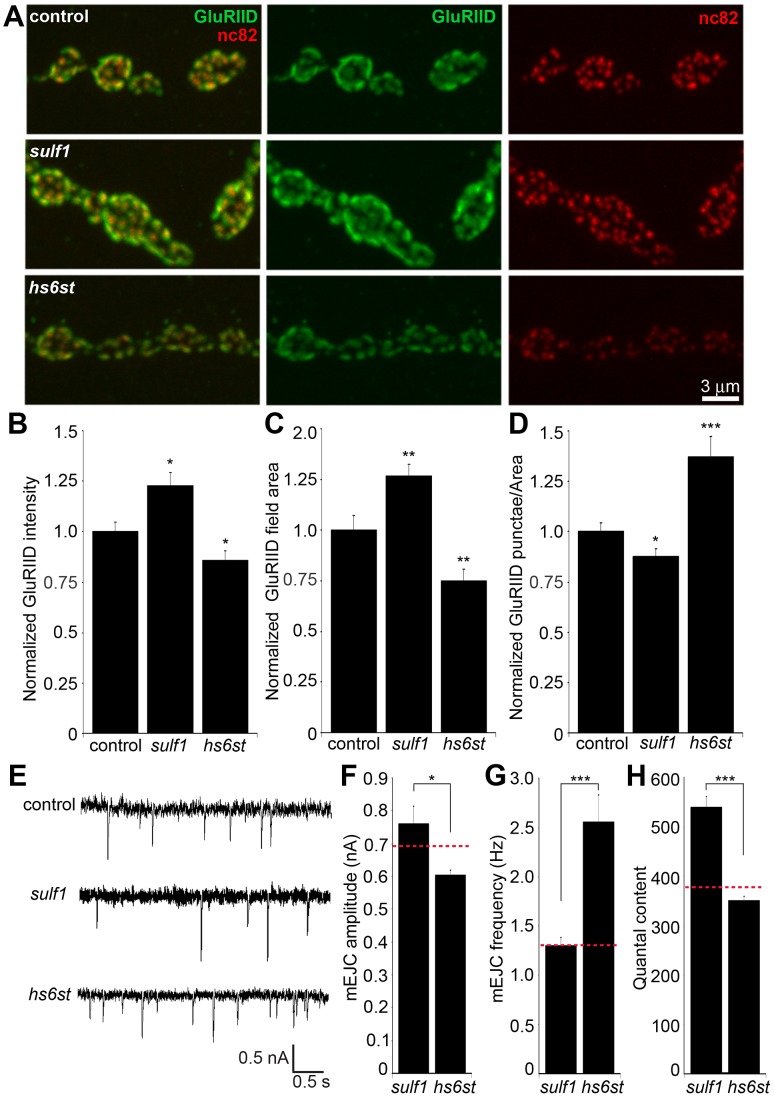
Bi-directional effects of sulf1 and hs6st nulls on synaptic assembly.(A) Representative NMJ boutons from control (w1118), sulf1 and hs6st null genotypes, labeled for postsynaptic Bad Reception (Brec) glutamate receptor IID subunit (GluRIID, green) and presynaptic active zone Bruchpilot (anti-nc82, red). Quantification of GluRIID mean fluorescent intensity (≥18 animals per indicated genotype) (B), GluRIID field area (≥40 boutons from ≥9 animals per indicated genotype) (C), and GluRIID punctae number per synaptic bouton (≥40 boutons from ≥9 animals per indicated genotype) (D), all normalized to genetic control. (E) Representative mEJC traces from control (w1118), sulf1Δ1 and hs6std770 null alleles. Quantified mean mEJC amplitude (nA) (F), mean mEJC frequency (Hz) (G) and mean quantal content (H), with genetic control levels indicated as a dotted red line in each case. Sample sizes ≥15 recordings per indicated genotype. Statistically significant differences calculated using student's t-test or Mann-Whitney test for non-parametric data and indicated as, * p<0.05, ** p<0.01, *** p<0.001. Error bars indicate S.E.M.